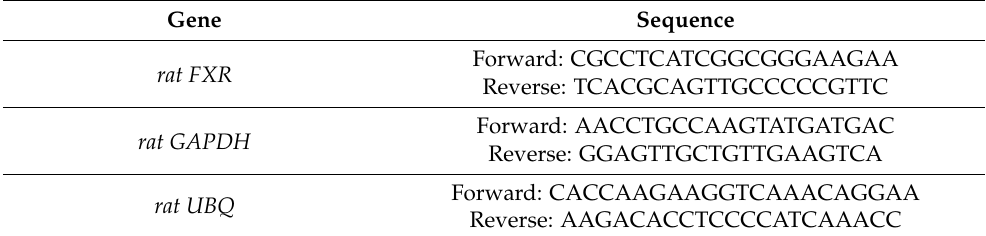
Table 2. List of forward and reverse primers used in the